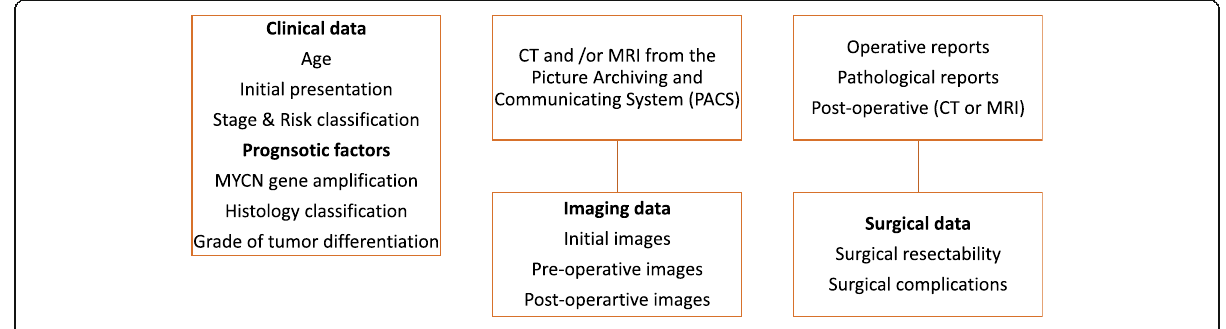
Fig. 1 The different data used in the research methodology